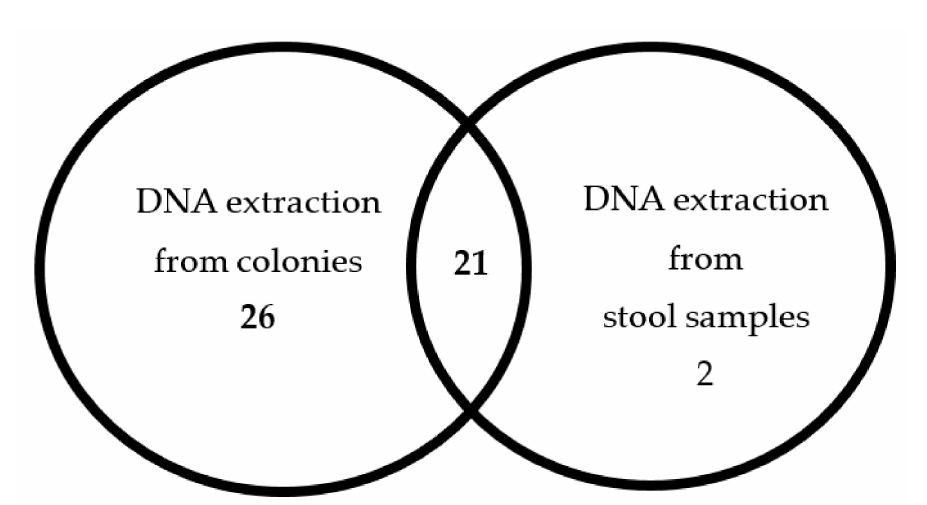
Figure 1. Number of positive samples for C. di ffi cile detected by each method for DNA